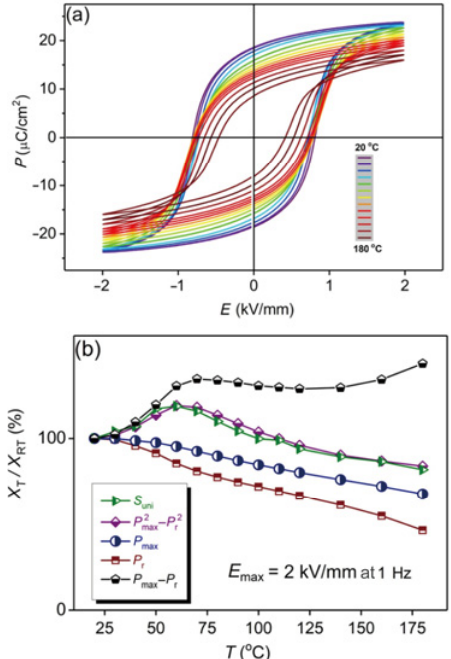
Fig. 9 (a) P  E loops of LKNNS  EuNZ  0.03BZ sample at different temperatures; (b) the summary of temperature dependence of S uni , P r , P max − P r , P max , and P 2 max − P 2 r at E max = 2 kV/mm.